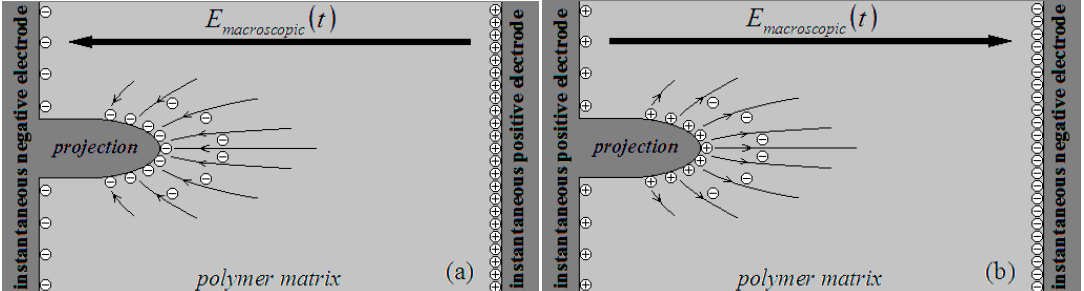
Figure 1. Schematic distributions of local electric field, free charges, and space charges around the top of the projection when E macroscopic ( t ) is ( a ) in the negative half-period and ( b ) in the positive half-period. The instantaneous polarities of the electrodes are labeled in the schematic diagram. In the negative half-period of